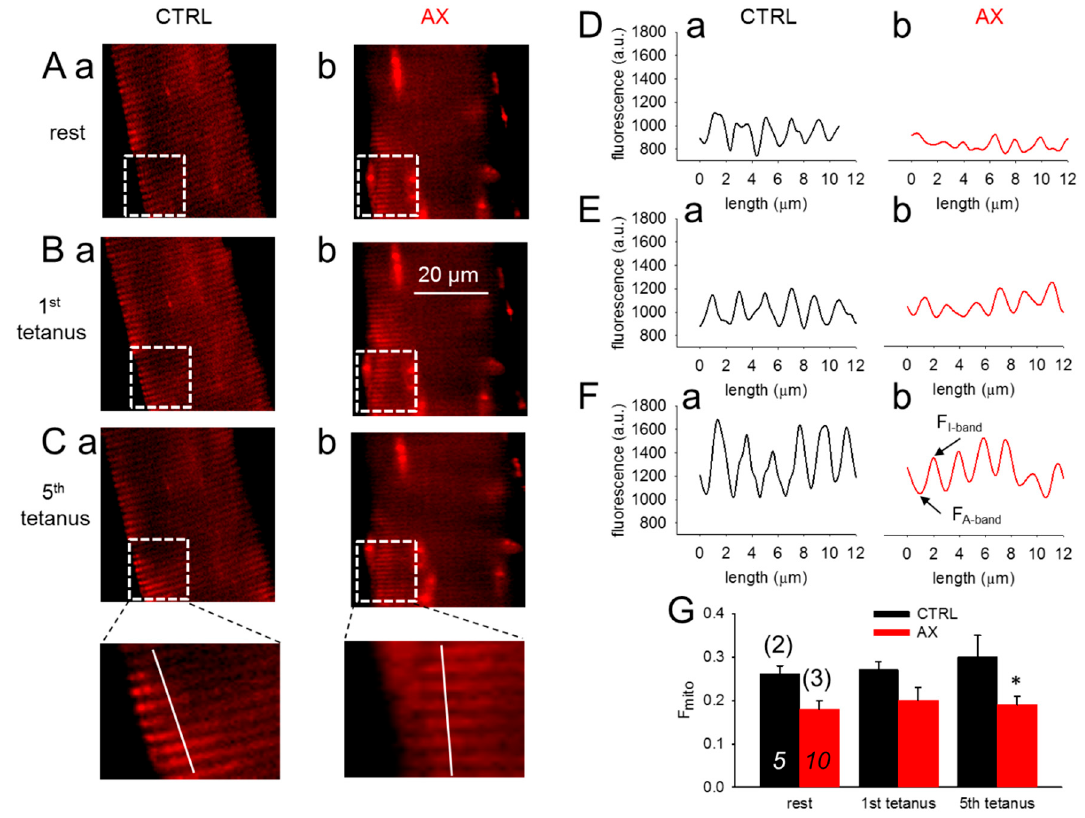
Figure 4. Decreased activity-dependent changes in mitochondrial calcium levels in single FDB fibers from AX mice. ( A – C ) Representative images of rhod-2 fluorescence in FDB fibers before and after tetanic stimulation (1st and 5th tetanus) in CTRL ( a ) and AX ( b ). ( D–F ) Representative mitochondrial fluorescence intensity profiles plotted from the highlighted square areas in images from Aa, Ba, Ca and Ab, Bb, Cb, respectively. ( G ) Average ( ± SEM) change of normalized mitochondrial fluorescence (F mito ) calculated as (F I-band – F A-band ) / F A-band in CTRL and AX FDB fibers at rest and following the tetanic stimulation. The numbers in italics indicate the number of cells studied, whereas the numbers in parenthesis denote the number of animals studied. Note the tendency of mitochondrial calcium accumulation and the di ff erences of the normalized F mito observed in control and AX. * denotes significant di ff erence between CTRL and AX, at p <